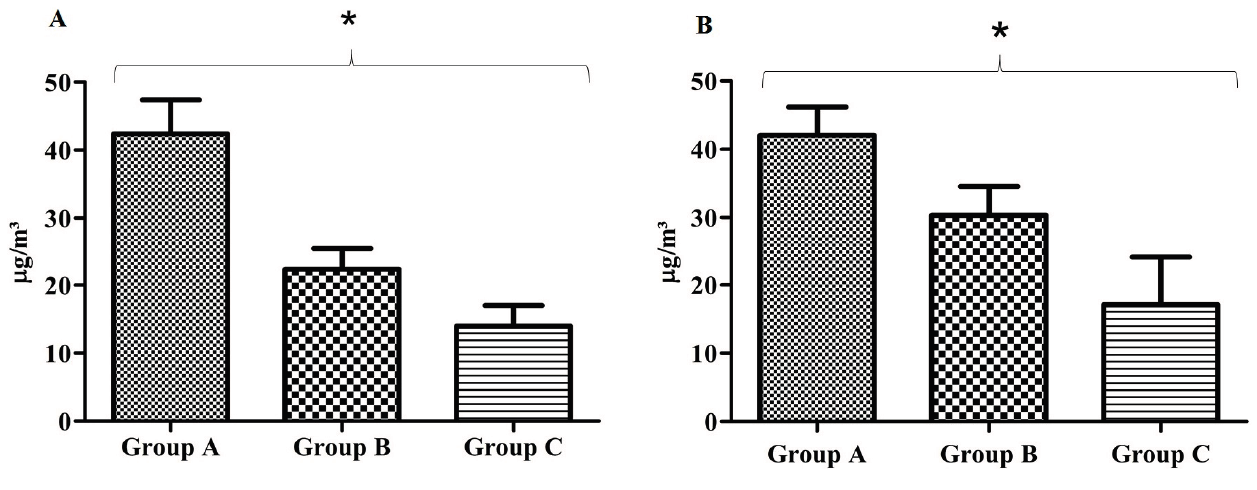
concentrations in the monitoring areas for summer ( A ) and winter ( B Figure 2. NO 2